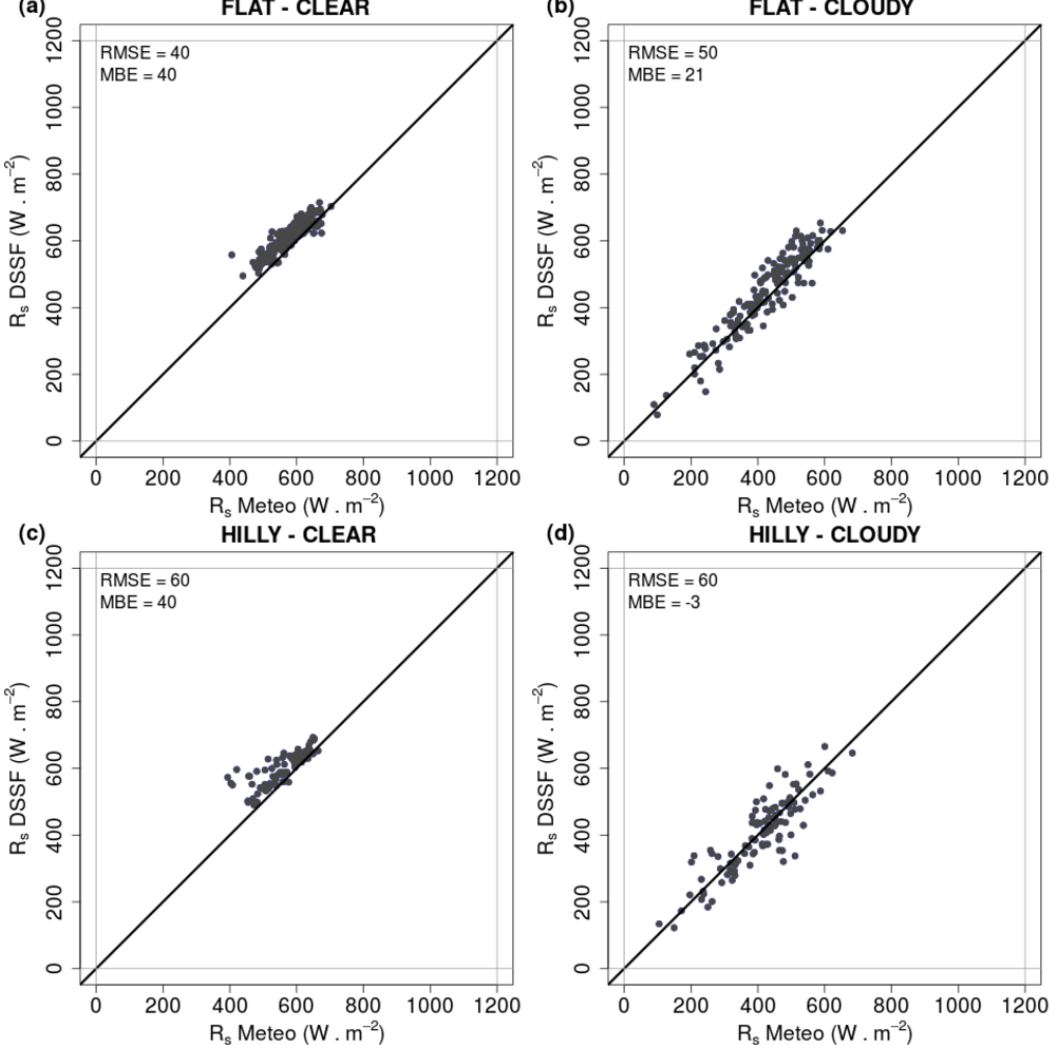
Figure 2. Daily Downwelling Surface Shortwave Flux (DSSF) (R s DSSF; W·m − 2 ) solar radiation vs. daily solar radiation measured at the surface weather stations (R s Meteo; W·m − 2 ) during the summer 2011, segmented based on terrain classes (flat and hilly) and atmospheric condition (clear and cloudy sky): flat-clear ( a ); flat-cloudy ( b ); hilly-clear ( c ) and hilly-cloudy ( d ). Statistical scores values (RMSE and MBE) presented in W·m − 2 .